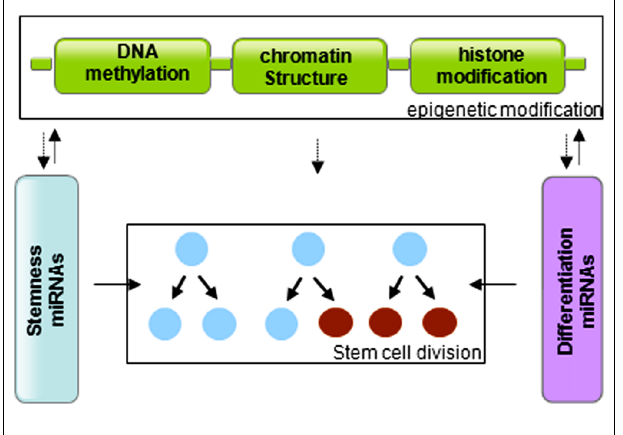
FIGURE 3 | Graphic of the reciprocal association between microRNAs and epigenetic modifications in control of stem cell